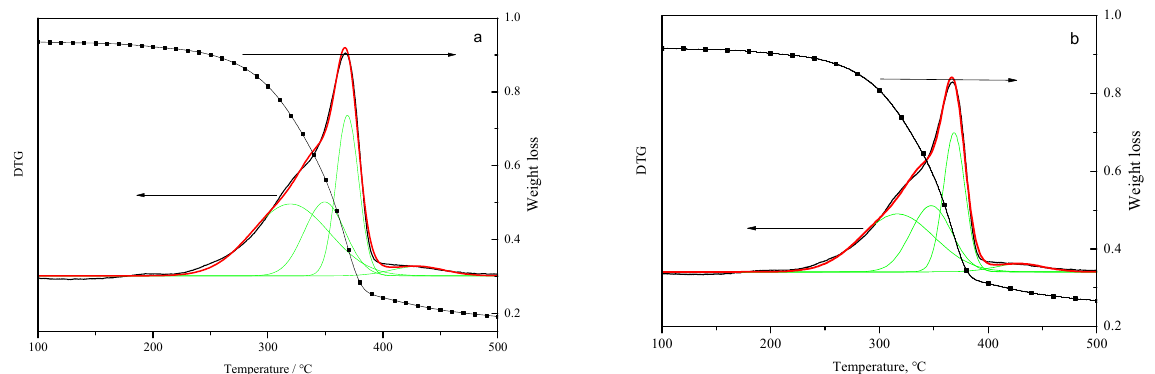
Figure 2. TG and DTG fitting curves between 100–500 ◦ C of pine and mixture: ( a ) pine and ( b ) mixture with an aluminum dross to pine mass ratio of